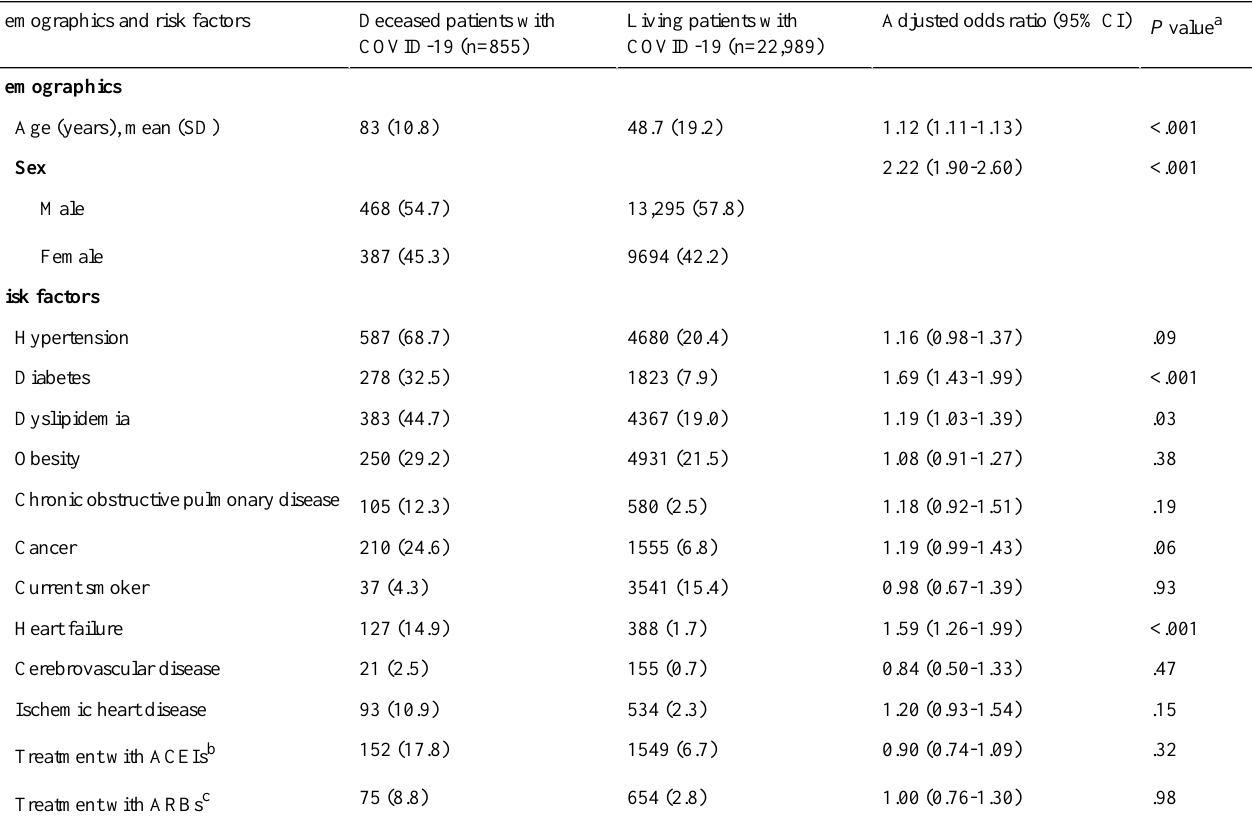
Table 2. Characteristics of deceased and living patients diagnosed with